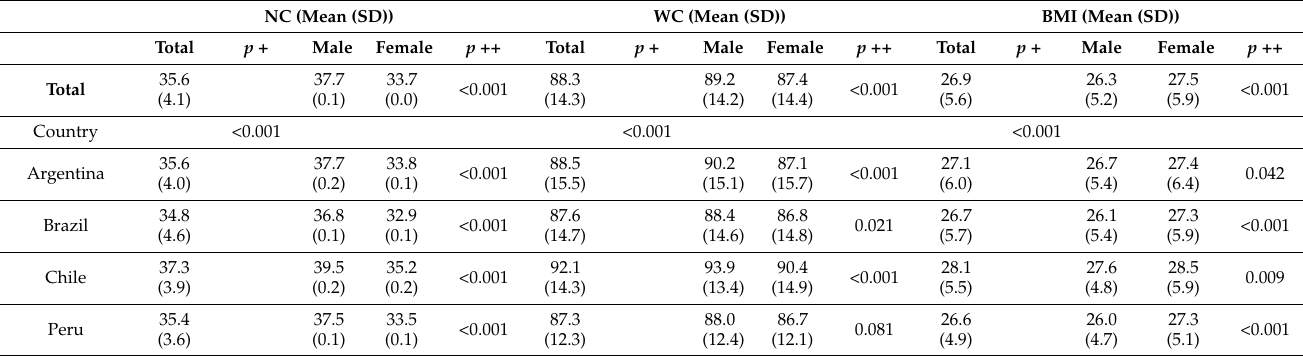
Table 2. Bivariate analysis for the total population and by sex between anthropometric measurements and variables of interest. Latin American Health and Nutrition Study/Estudio Latino Americano de Nutrici ó n y Salud